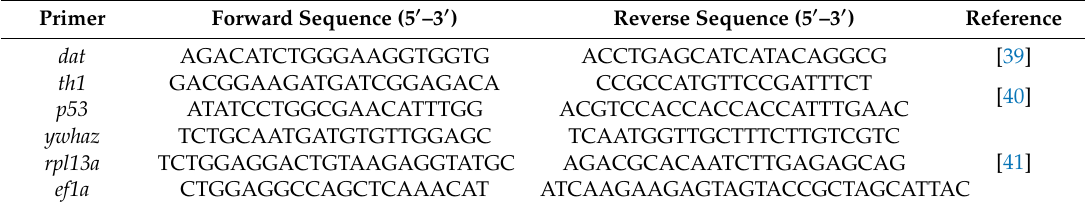
Table 1. List of primers designed for